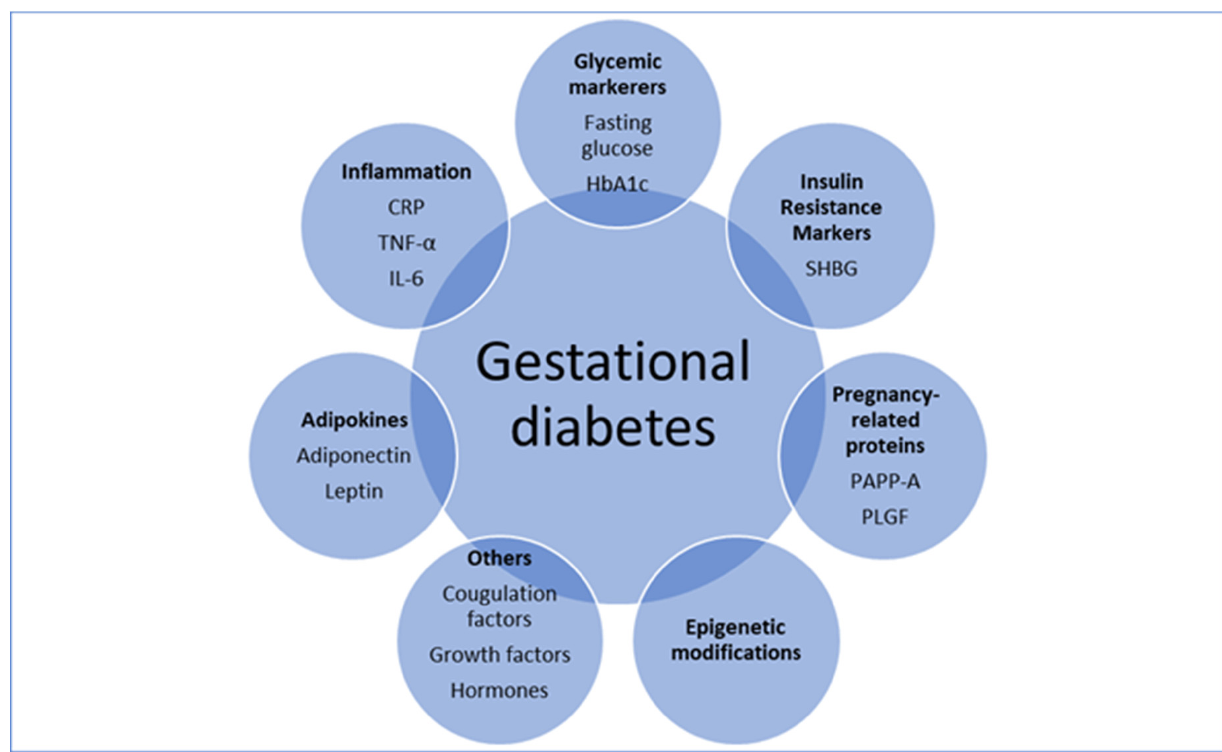
Figure 1. Overview of tested biomarkers. CRP—C-reactive protein; IL-6—interleukin 6; PAPP- A—pregnancy-associated plasma protein A; PLGF—placental growth factor; SHBG—sex hormone- binding globulin; and TNF- α —tumor necrosis factor α